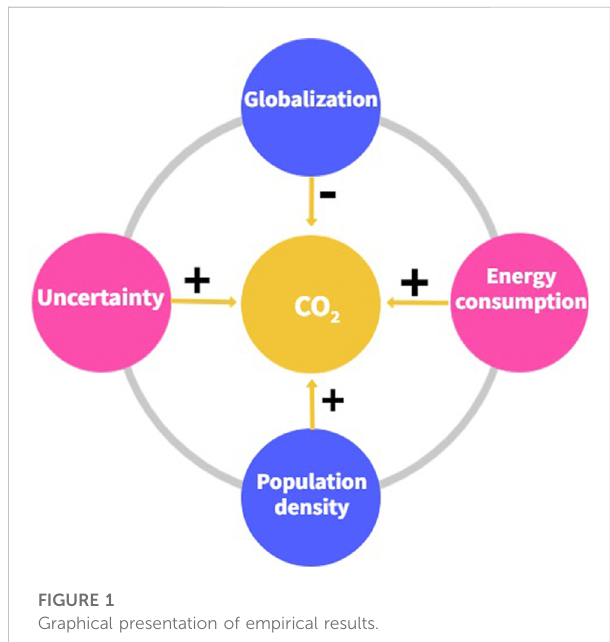
FIGURE 1 Graphical presentation of empirical